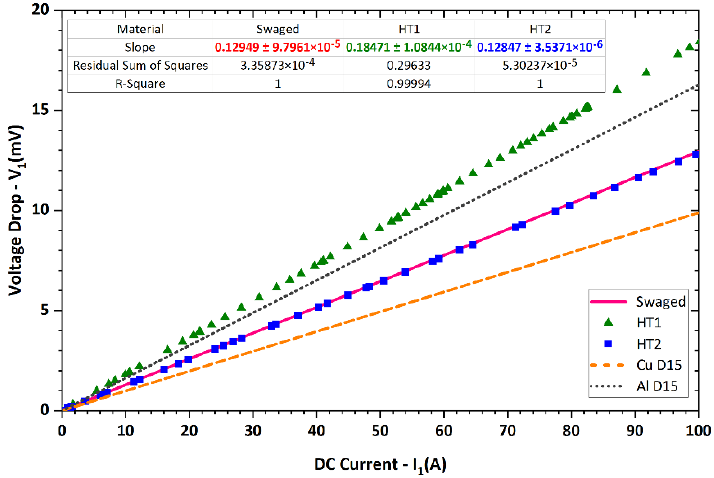
Figure 11. Experimentally acquired dependences of voltage drop on applied direct current for swaged and heat-treated laminates and for swaged original metals.